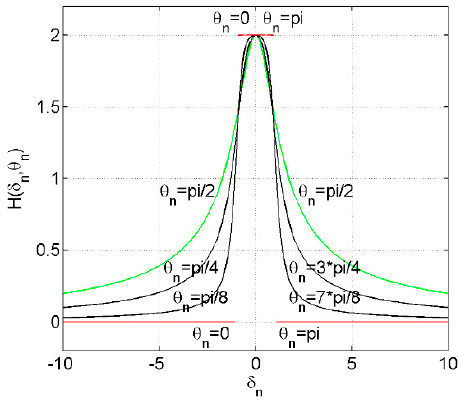
Figure 4. Function H ( δ n , θ n ) for different values of the angle θ n .